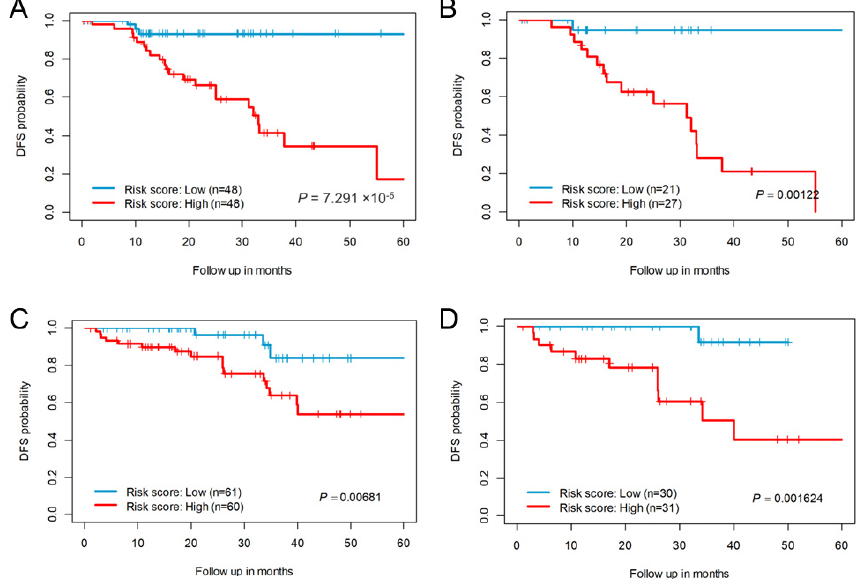
Figure 3. Survival estimates of enhancer RNA signature for disease-free survival probability. ( A ) Kaplan–Meier plots show low- and high-risk score groups based on the median risk score of the colon cancer CM4 subtype cohort ( B ) Survival estimates of randomly selected 50% of the colon can- cer CMS4 subtype cohort. Kaplan–Meier plots show low- and high-risk score groups based on the median risk score threshold value from the entire colon cancer CMS4 cohort. ( C ) Kaplan–Meier plots show low- and high-risk score groups based on the median risk score of the rectal cancer cohort ( D ) Survival estimates of randomly selected 50% of the rectal cancer cohort. Kaplan–Meier plots show low- and high-risk score groups based on the median risk score threshold value from the entire rectal cancer cohort. The p values were obtained using a Mantel log-rank test (two-sided). DFS = Disease-free survival. 2.3. Recurrence Prediction by eRNA Signature Is Independent of Clinical Risk Factors